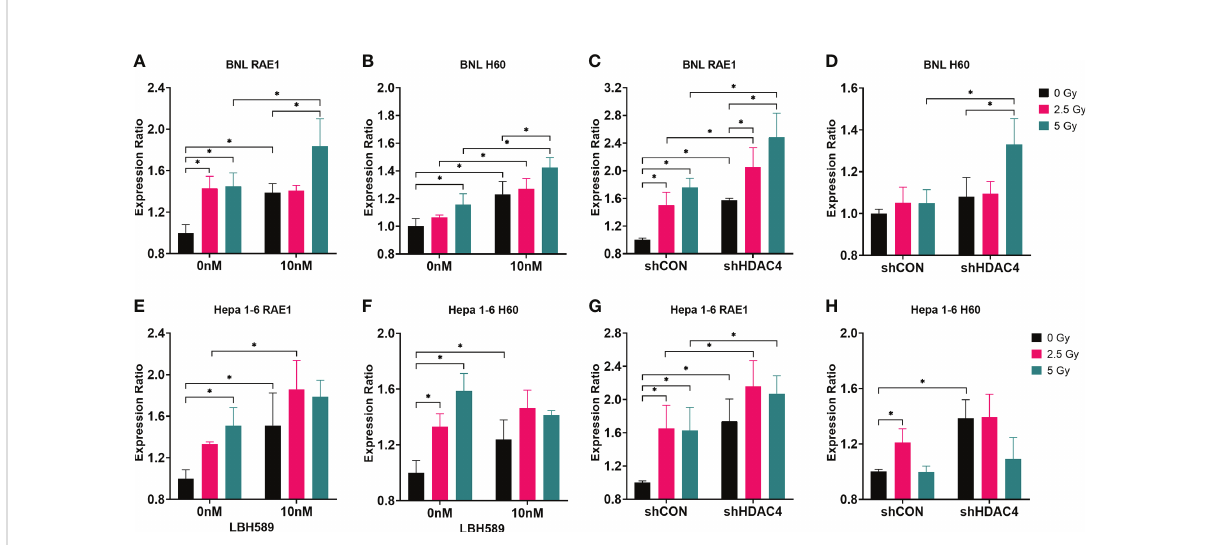
FIGURE 3 Effect of HDAC inhibition and radiotherapy (RT) on NKG2D ligand expressions in murine HCC cells. (A, B, E, F) Wild-type BNL cells and Hepa 1-6 cells were treated with 10 nM of a pan-HDAC inhibitor, LBH589; (C, D, G, H) vector-control shRNA (shCON) and HDAC4 shRNA knockdown (shHDAC4) BNL cells and Hepa 1-6 cells were irradiated at 0, 2.5 Gy, or 5 Gy. Combined LBH589 or shHDAC4 and RT signi fi cantly increased the expression of NKG2D ligand RAE1 but only partially increased H60 expression in murine HCC cells. Error bars indicate SD, *P < 0.05.